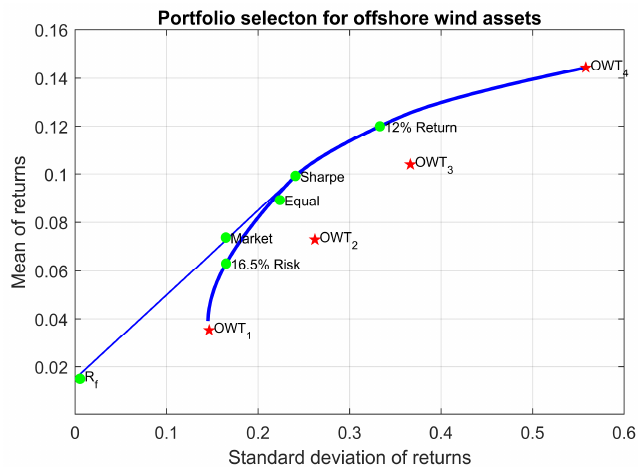
Figure 13. Optimal portfolio at the maximum Sharpe ratio.